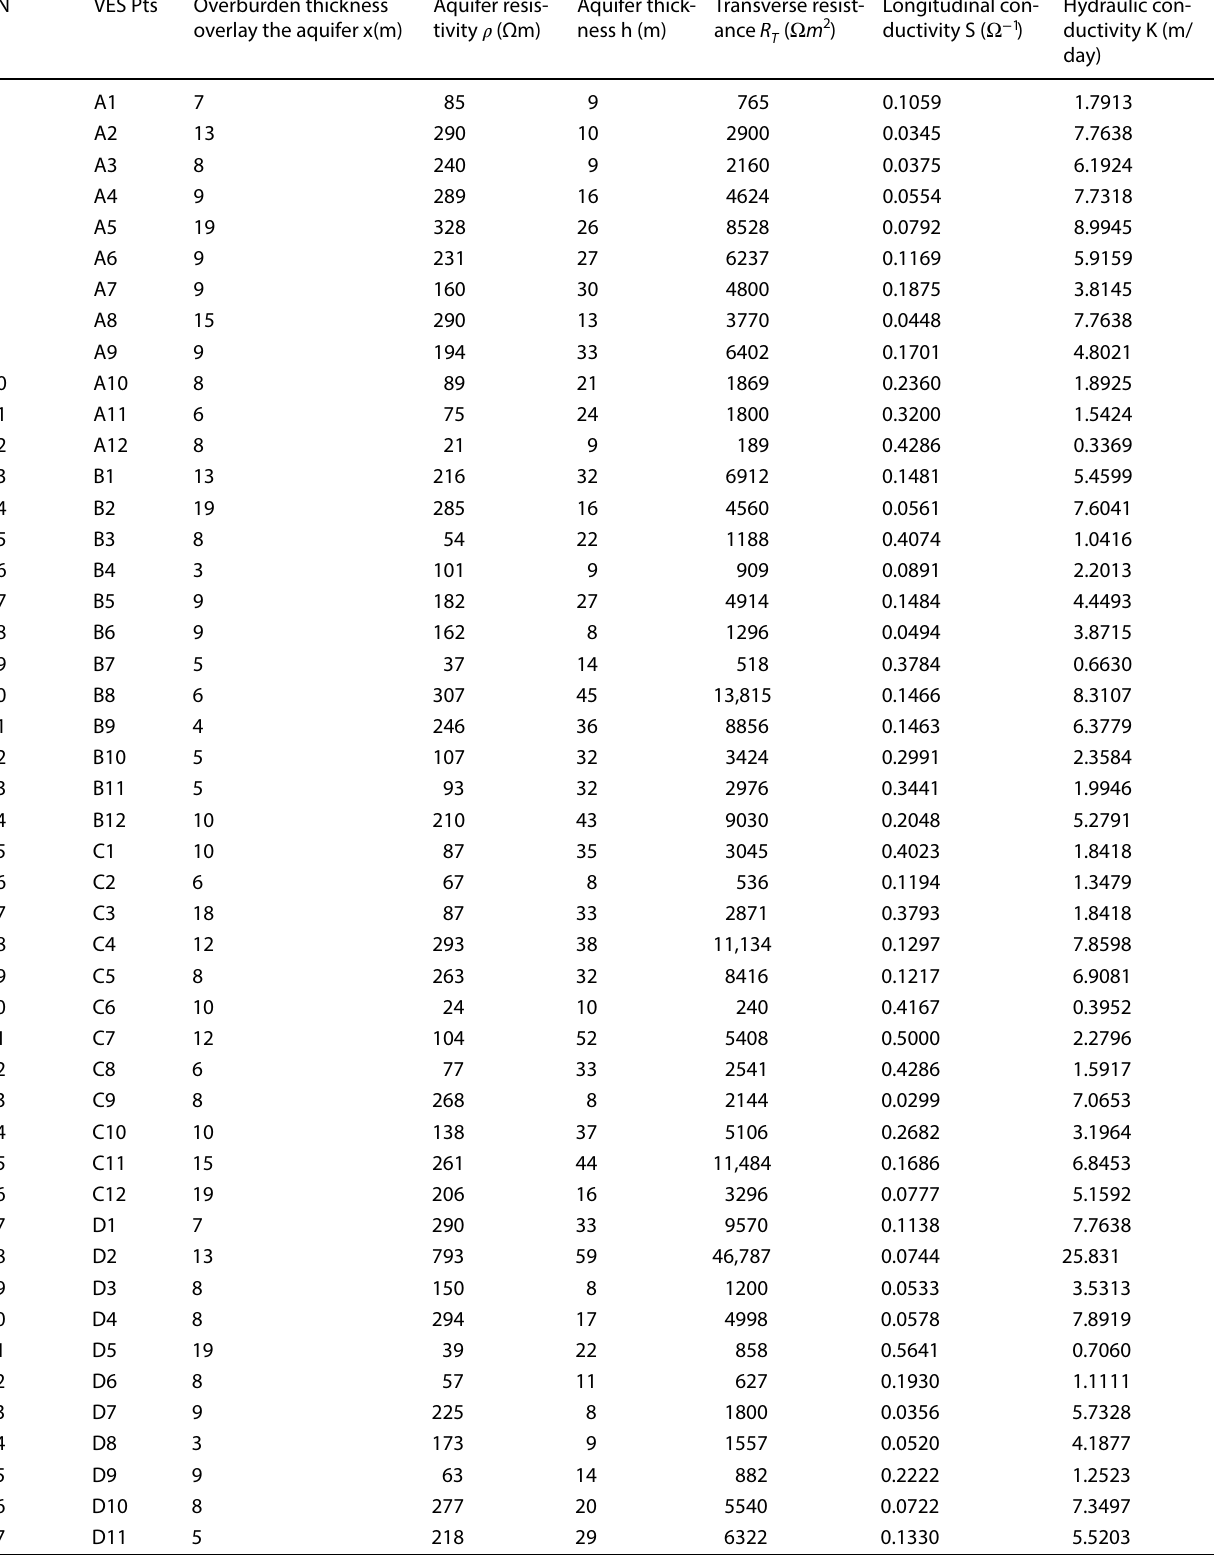
Table 2 The Summary of the aquifer parameters estimated from the geoelectric parameters across the sixty (60) VES stations of the case